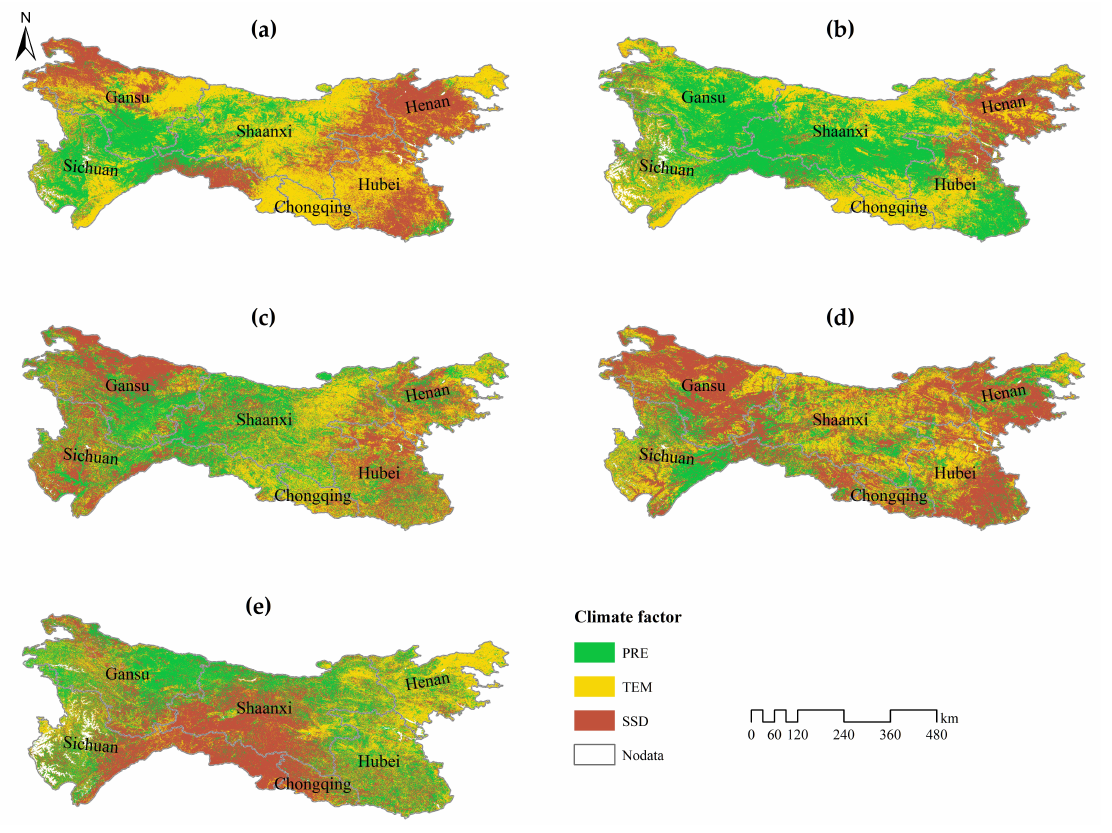
Figure 16. Main climate factors of average FVC in the QBM. ( a ) Year; ( b ) Spring; ( c ) Summer; ( d ) Autumn; ( e ) Winter.